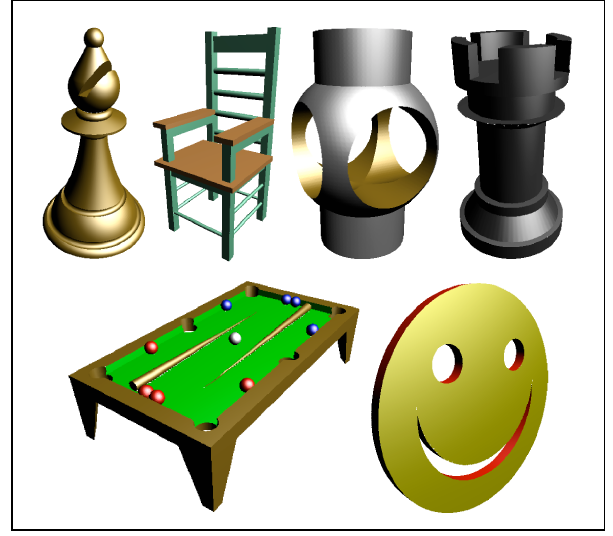
Figure 3. Rendering of splat-based